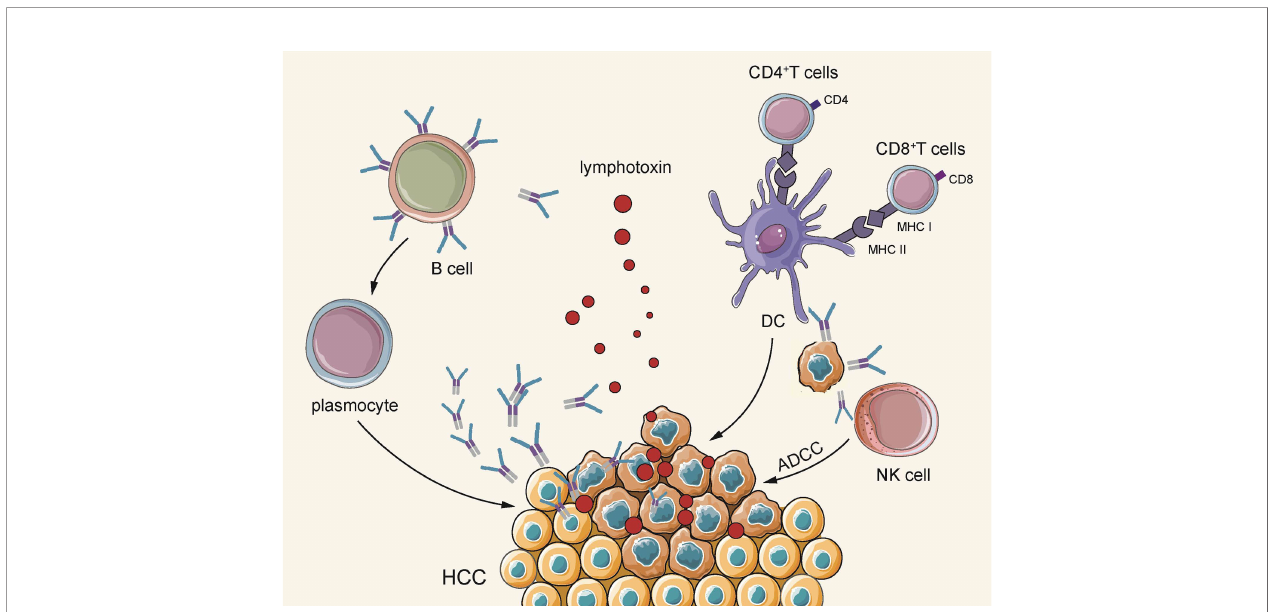
FIGURE 2 | On the one hand, B cells secrete lymphotoxin through TLS, and plasma cells secrete antigen-speci fi c antibodies to directly kill tumors. On the other hand, they indirectly play an anti-tumor effect by acting as APC to activate cellular immunity and activate the natural killing effect of NK